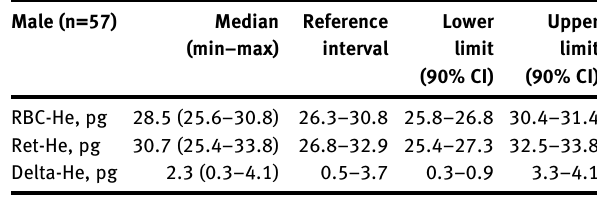
Table  : Reference intervals for the erythrocyte and reticulocyte parameters.